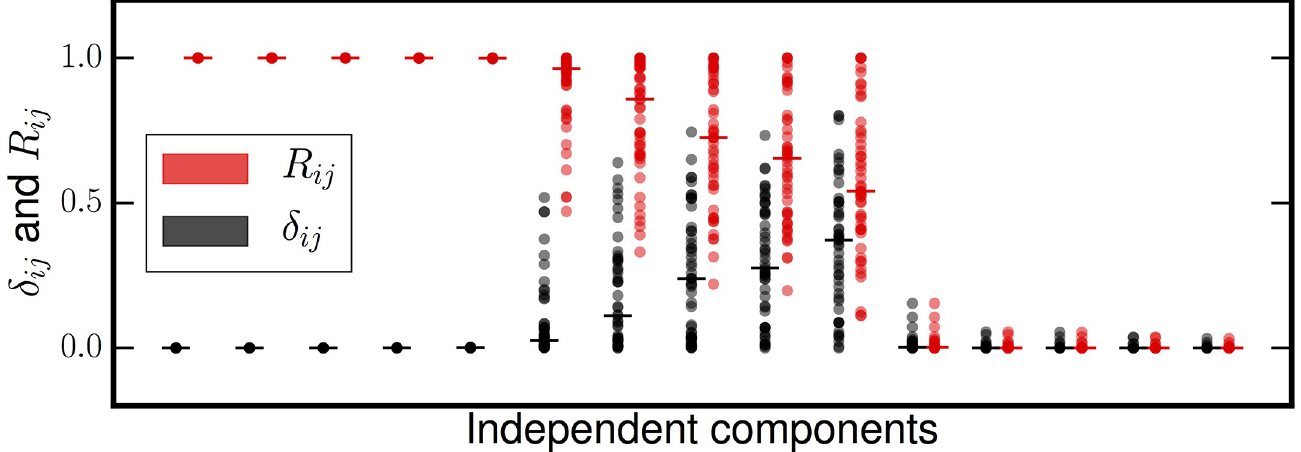
Fig 5. Reproducibility ( R ) and reproducibility fluctuations ( δ ij ) for speech signals mixed with Gaussian sources. For each of the fifteen extracted sources, R is shown in red and δ ij in black. For both quantities, values for each of the fifty subsampleddata matrices are shown as points and the median value as a horizontal bar. The sources clearly group into three categories:high R with low δ ij (true sparse sources), variable R with high δ ij (Gaussian sources), and low R and δ ij (spurioussources).